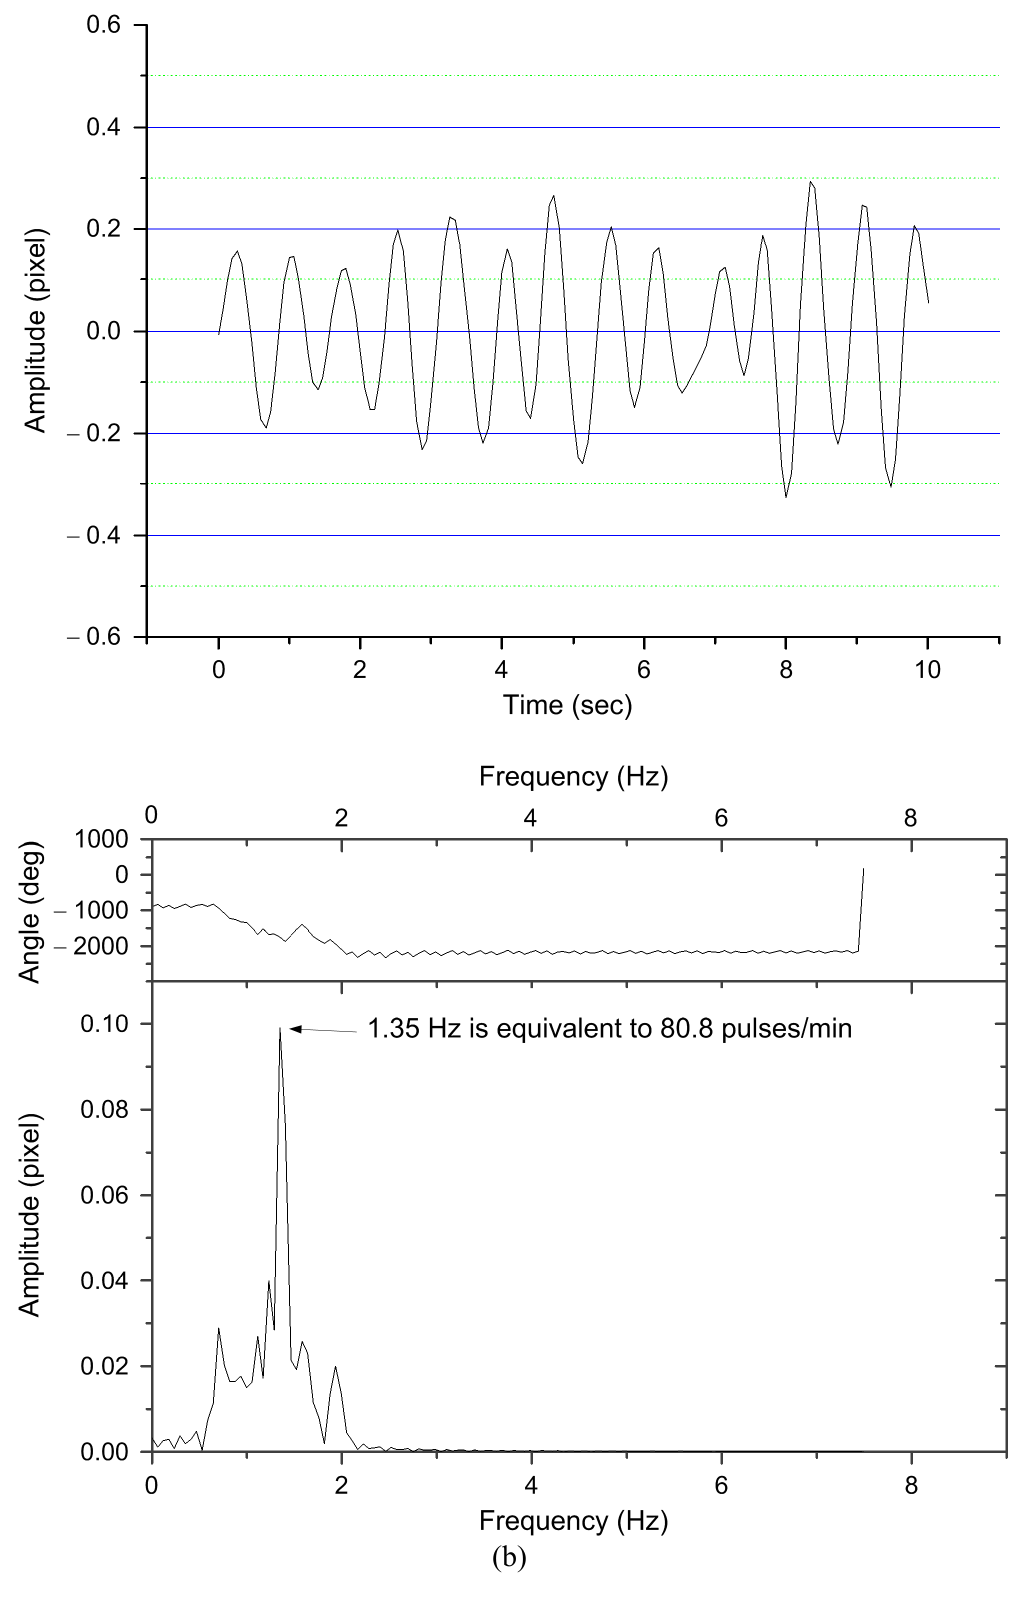
Figure 12. Pulse information measured at the Chun point on the left hand (small intestine) of the tested subject: (a) 30 min before a meal ( to be continued